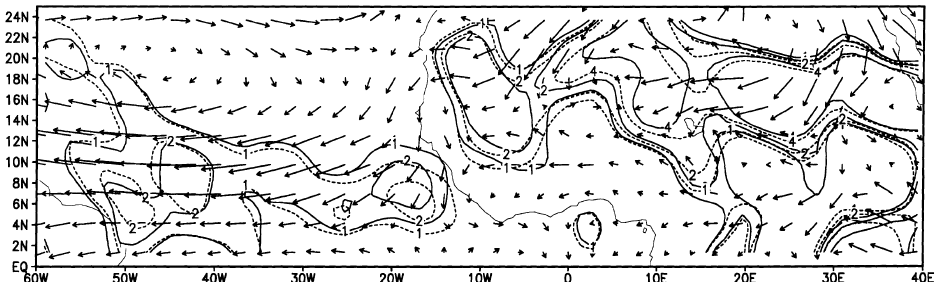
Fig. 4. Simulated 900-hPa wind anomalies for the ‘‘ENSO’’ run relative to the control run. Vector length : 5 (cid:176) longitude for 2 ms (cid:41) 1 . Full ( dashed ) lines represent the 900-hPa wind convergence for the control (‘‘ENSO’’) run. Isolines are in 10 (cid:41) 6 s (cid:41)